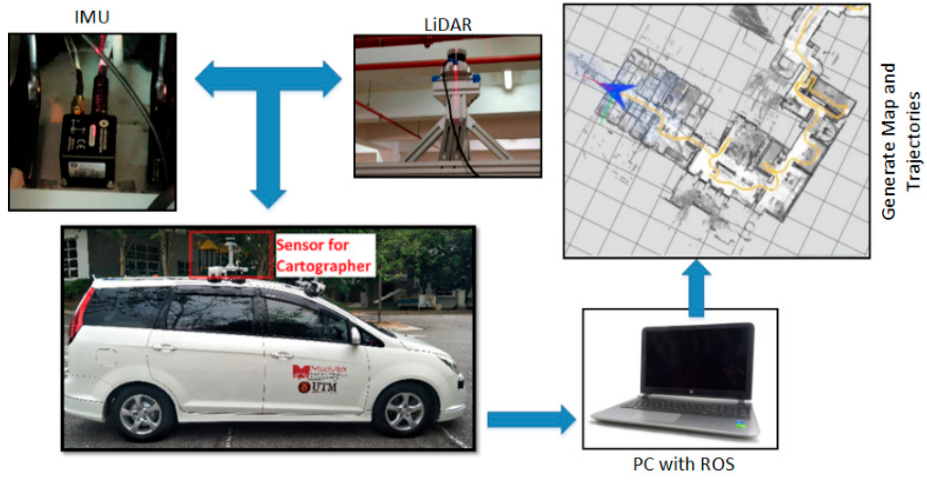
Figure 7. An MPV sized vehicle for SLAM configuration.